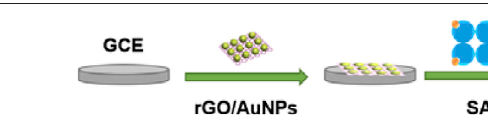
FIGURE 1 | Scheme of the preparation of BSA/Bio-Ab/SA/AuNPs/rGO/GCE.